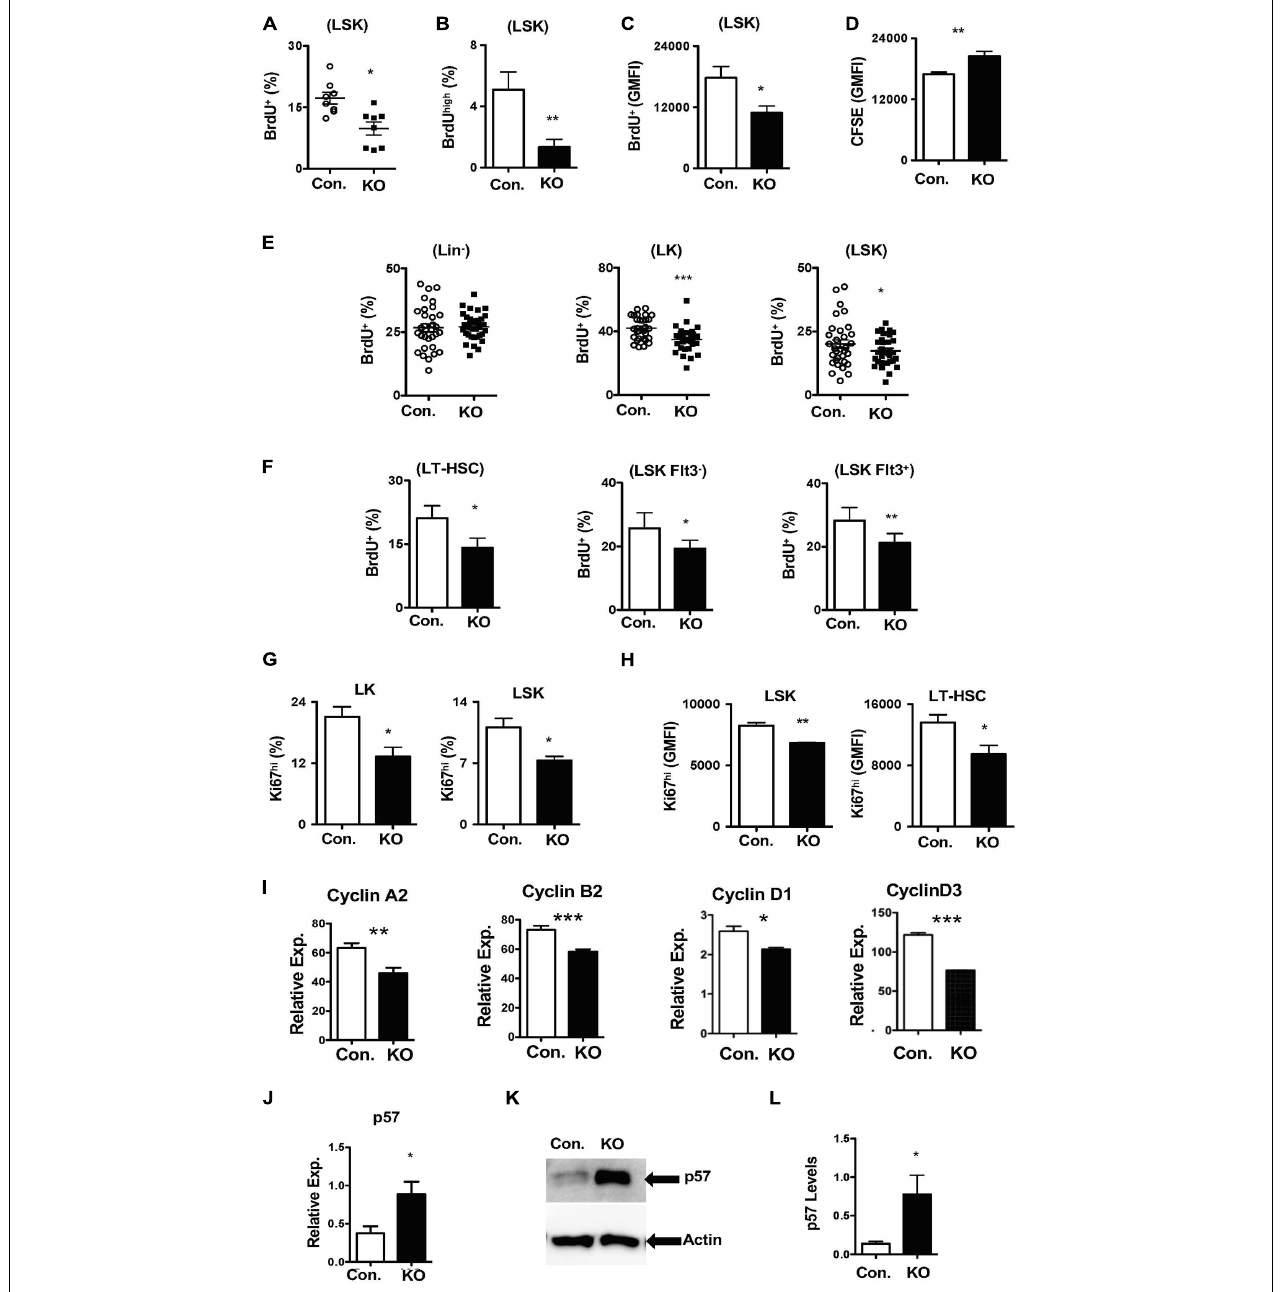
FIGURE 5 | Loss of Rbpj results in increased HSC quiescence. (A,B) Frequencies of BrdU + (A) and BrdU high (B) LSK cells following in vitro culture of purified Lin − BM cells from KO and Control mice in the presence of HSPC cytokine cocktail for 24 h. Data are pool of two independent experiments ( n = 8–12). (C) Geomean fluorescence Intensity (GMFI) of BrdU + LSK cells following in vitro culture of purified Lin − BM cells from KO and Control mice in the presence of HSPC cytokine cocktail for 24 h. Data are pool of two independent experiments ( n = 8–12). (D) GMFI of CFSE in LSK cells following in vitro culture of purified Lin − BM cells from KO and Control mice in the presence of HSPC cytokine cocktail for 72 h. Data are pool of two independent experiments ( n = 5–7). (E,F) Frequencies of BrdU + Lin − , LK, LSK, LT-HSCs, Flt3 − LSK and Flt3 + LSK subsets in the BM of KO and Control mice ( n = 20–22). Mice were injected i.p., with BrdU and analyzed after 24 h. (G,H) Frequencies of Ki67 + LK and LSK cells (G) and GMFI of Ki67 high LSK cells and LT-HSCs (H) in the BM of KO and Control mice ( n = 10–12). (I) Real time PCR data for Cyclin A2, Cyclin B2, Cyclin D1 , and Cyclin D3 expression levels in Lin − cells from the BM of KO and Control mice. Expression levels of target genes were normalized to HPRT levels. Data are representative of two independent experiments. (J) Real time PCR data for p57 Kip 2 expression levels in Lin − cells from the BM of KO and Control mice. Expression levels were normalized to HPRT levels. Data are representative of three independent experiments. (K) Western blot analysis of p57 Kip2 protein in Lin − BM cells of KO and control mice. Data are representative of three independent experiments. (L) Quantification of proteins from western blots shown in (K) p57 Kip2 protein levels were normalized to actin protein levels in each lane, respectively. Data are pool of three independent experiments. All data represent mean ± SEM. Two-tailed Student’s t- tests were used to assess statistical significance (* P < 0.05; ** P < 0.01; *** P < 0.001).